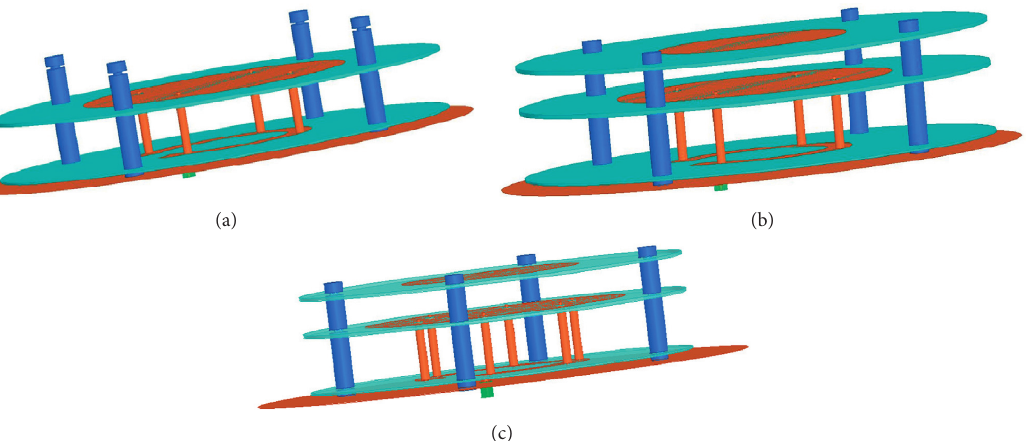
Figure 2: Three CP antennas. (a) Antenna 1. (b) Antenna 2. (c) Proposed antenna.